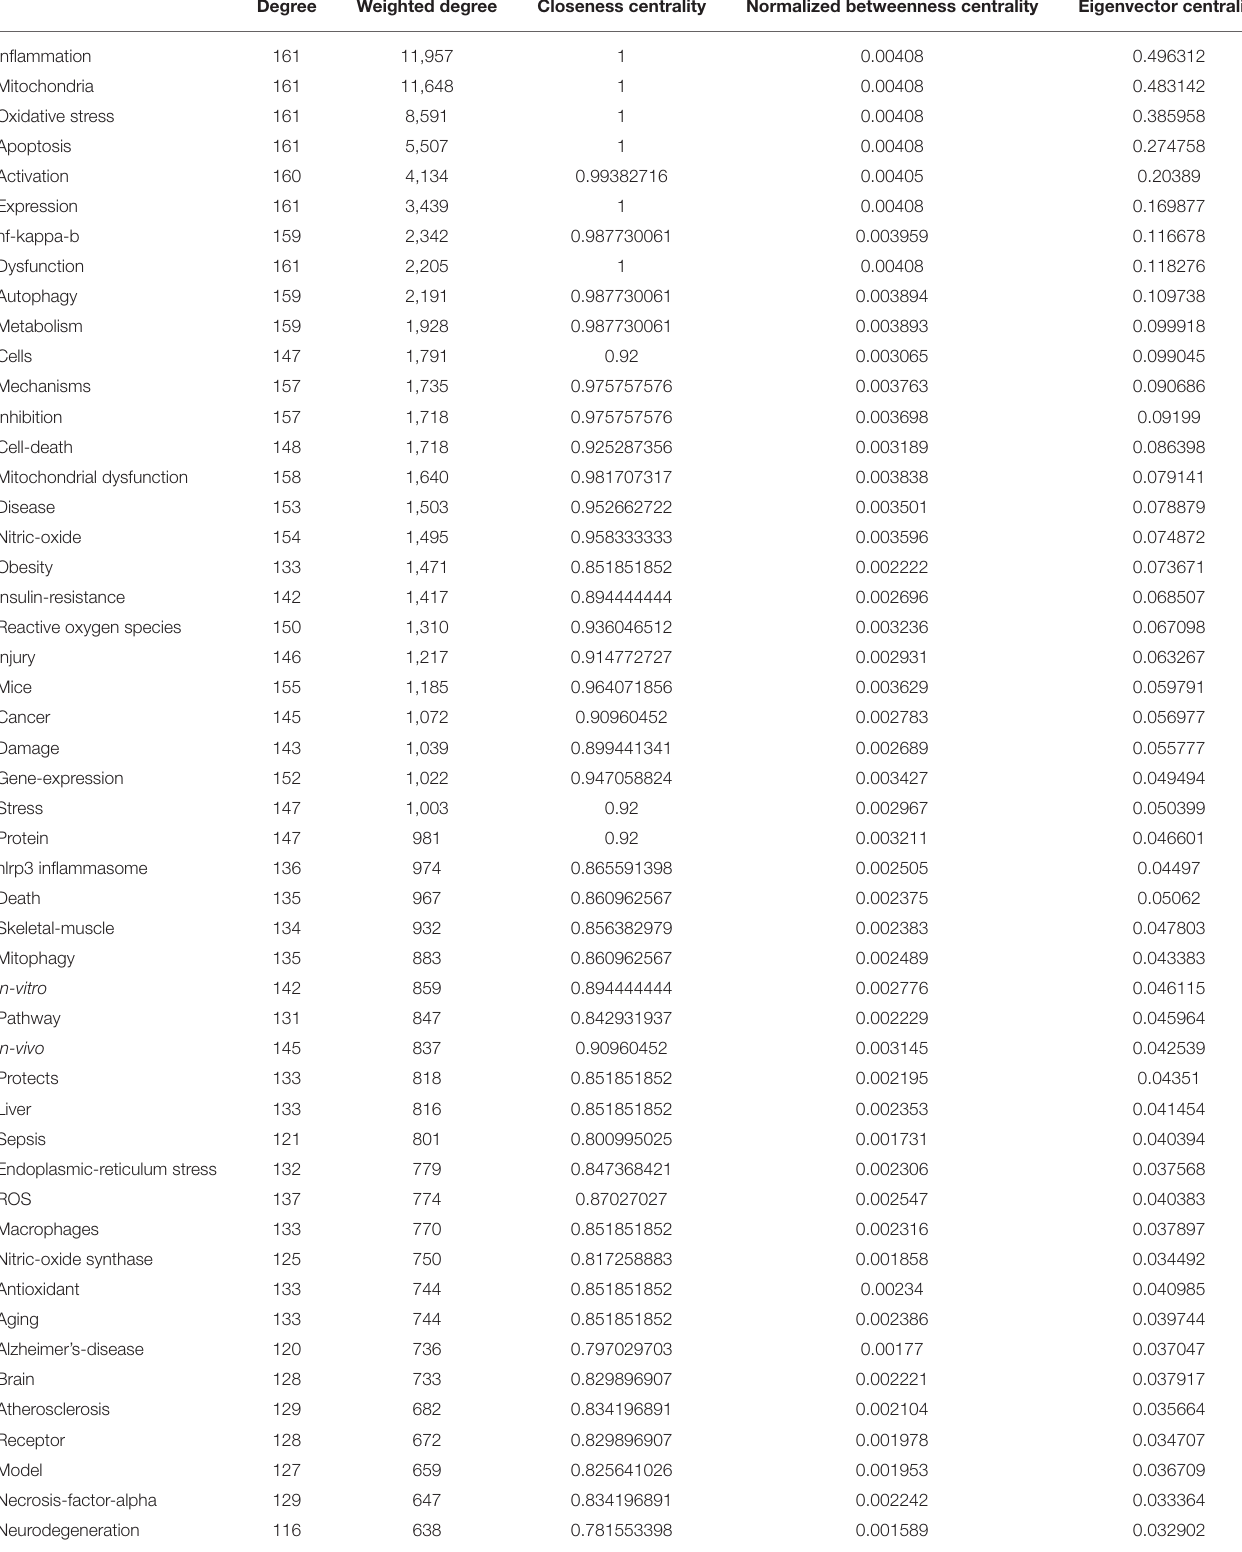
TABLE 1 | Network metrics for top 50 co-occurrence keywords associated with inflammation & mitochondria. Degree Weighted degree Closeness centrality Normalized betweenness centrality Eigenvector